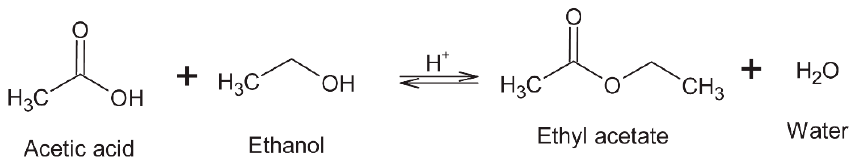
Figure 8. Production of ethyl acetate during fermentation.